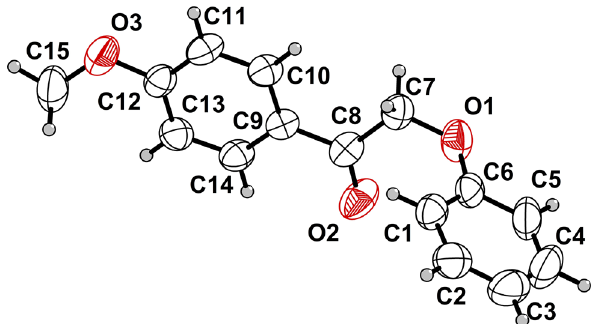
Table  : Data collection and handling.